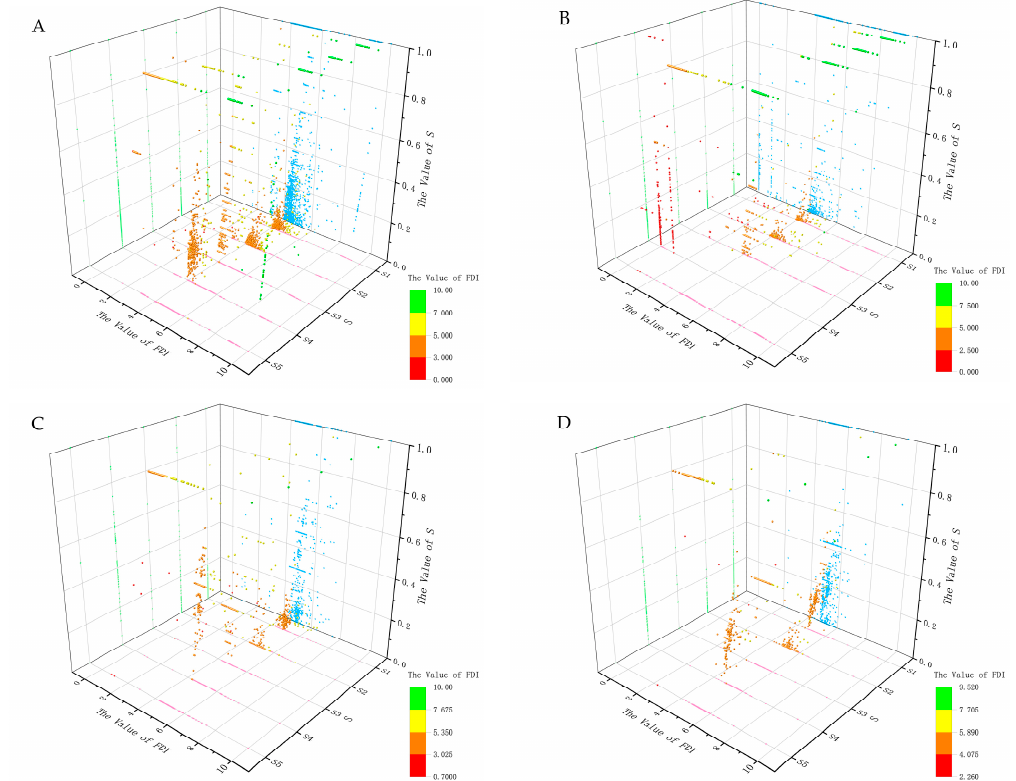
Figure 3. Distribution degradation levels of different forest types divided by dominant species in the Guangdong province and Tibet autonomous region; ( A ) Distribution of broad-leaved mixed forest in the Guangdong province; ( B ) Distribution of eucalyptus forest in the Guangdong province; ( C ) Distribution of fir forest in the Tibet autonomous region; ( D ) Distribution of spruce forest in the Tibet autonomous region. FDI: forest degradation index; S values: methodological description of obtaining these values is provided in a Section 2.6 (Normalizing the indicators) whereby S1: Forest accumulation growth rate after standardization of each sample plot; S2: Forest recruitment rate after standardization of each sample plot; S3: Tree species reduction rate after standardization of each sample plot; S4: Forest canopy cover reduction rate after standardization of each sample plot; S5: Forest disaster level after standardization of each sample plot; The pink points represent the projection of the plots on “S” ( X -axis) and “The Value of FDI” ( Y -axis); The light green points represent the projection of the plots on “S” ( X -axis) and “The Value of S” ( Z -axis). The blue points represent the projection of plots on “The Value of FDI” ( Y -axis) and “The Value of S” ( Z -axis).